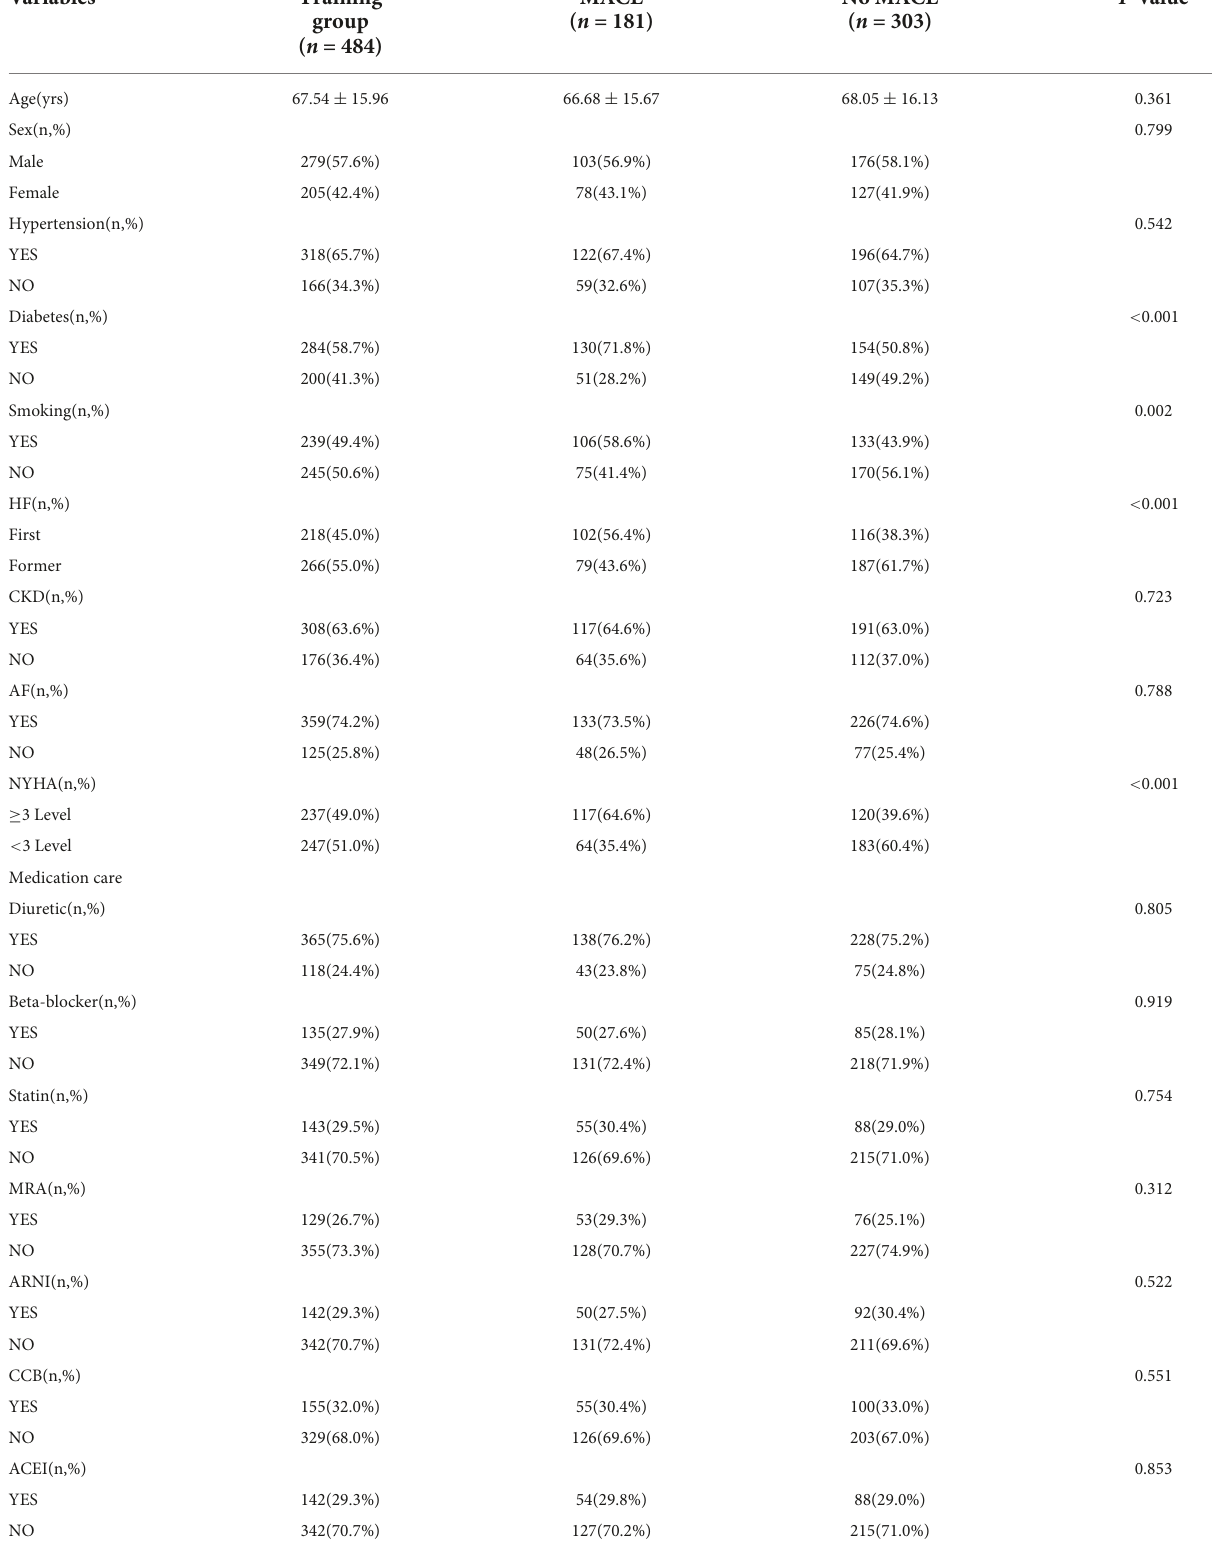
TABLE 2 Univariate analyses of variables associated with MACE in the training